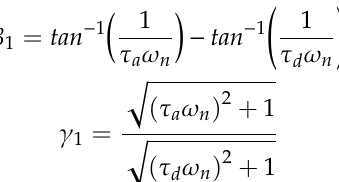
Figure 3. Command separation for start motion. ( a ) Equivalent command process and range division; ( b ) Segmented velocity profiles.